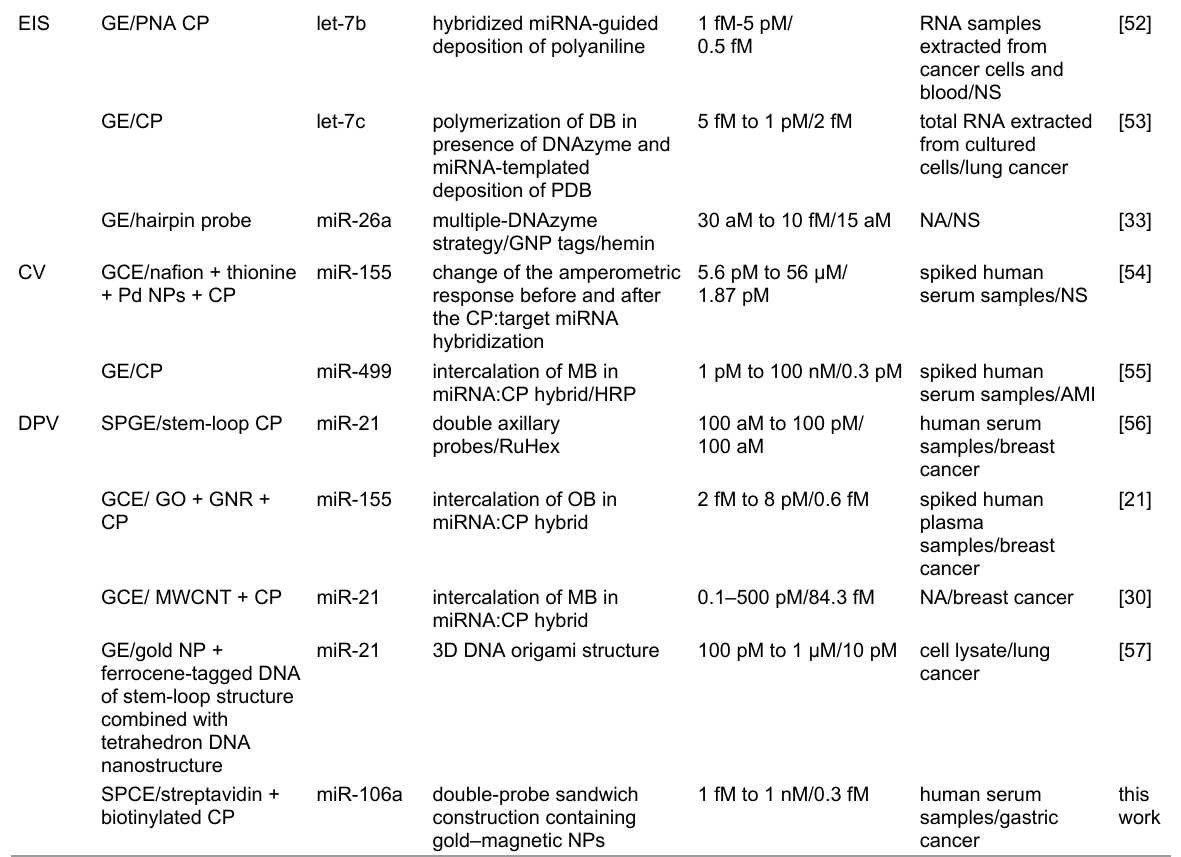
Table 3: The comparison of the proposed electrochemical nanobiosensor specifications with selected recently published electrochemical biosensors for the detection of miRNA. a (continued)